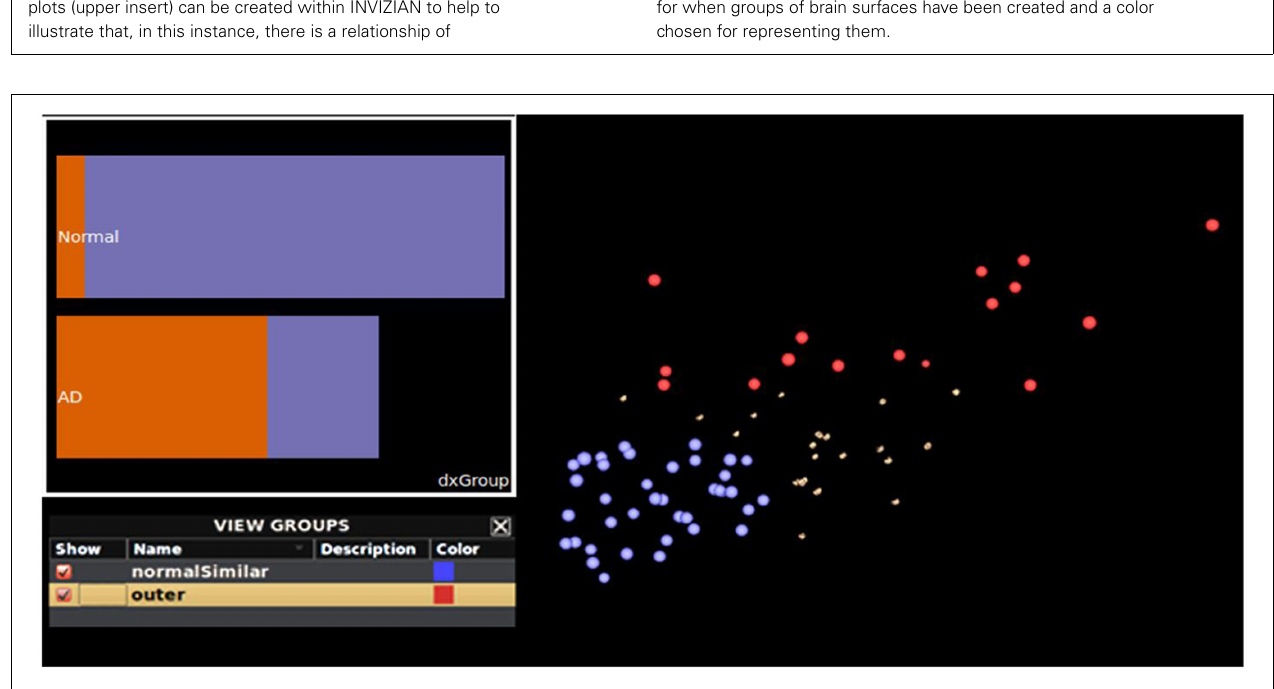
presented as the bottom-most bar.The length of each bar represents the total number of subjects per subject meta-data category.This helps to illustrate that the most of the normal subjects are members of the blue feature-similar cluster, and vice versa.This can be particularly helpful when examining and performing grouping operations on large collections of subject